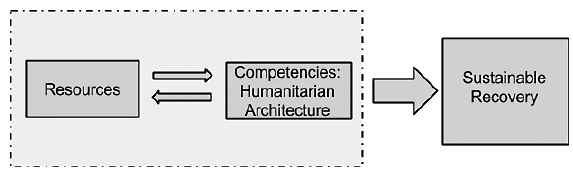
fig. 1. Strength Based approach (Mooney et al .